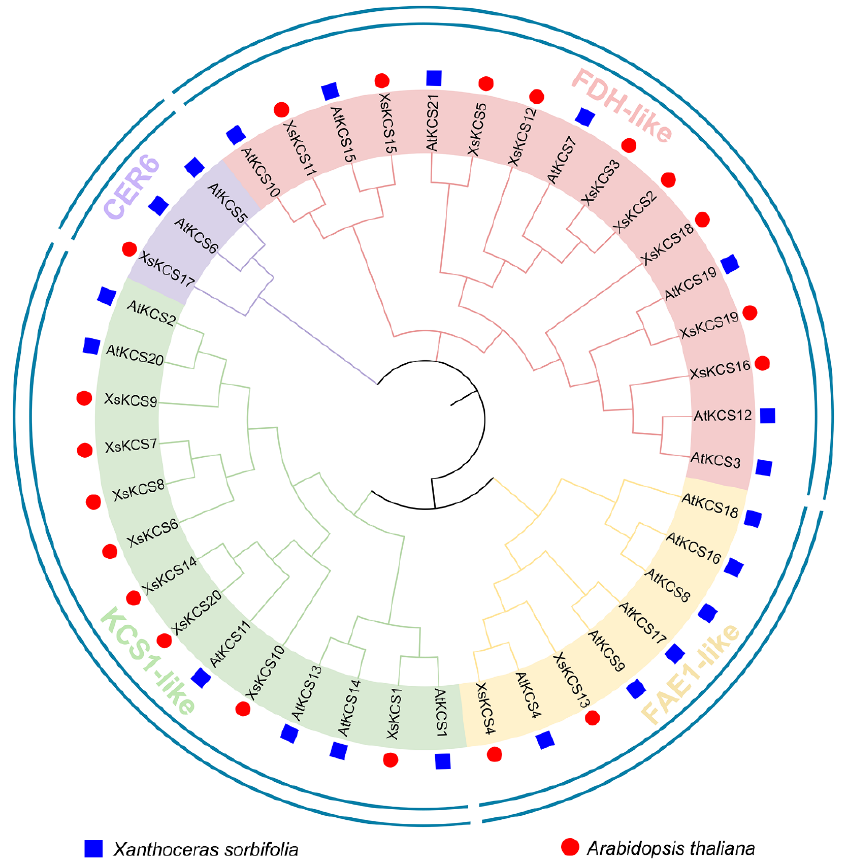
Figure 1. Phylogenetic tree of XsKCS genes family. The 41 predicted KCS proteins from Arabidopsis thaliana and Xanthoceras sorbifolia were aligned using ClustalW. Four subfamilies are represented by the different colored lines.